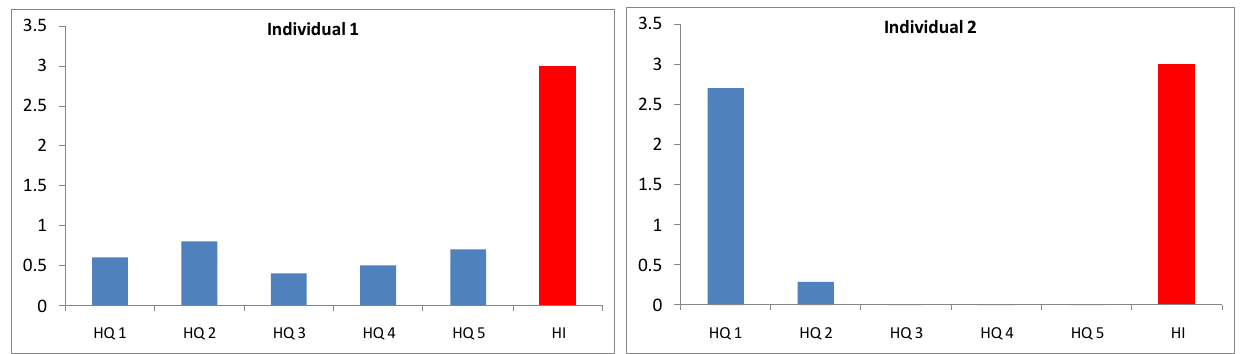
Figure 1. Illustration of MCR as a predictor of the need for cumulative risk